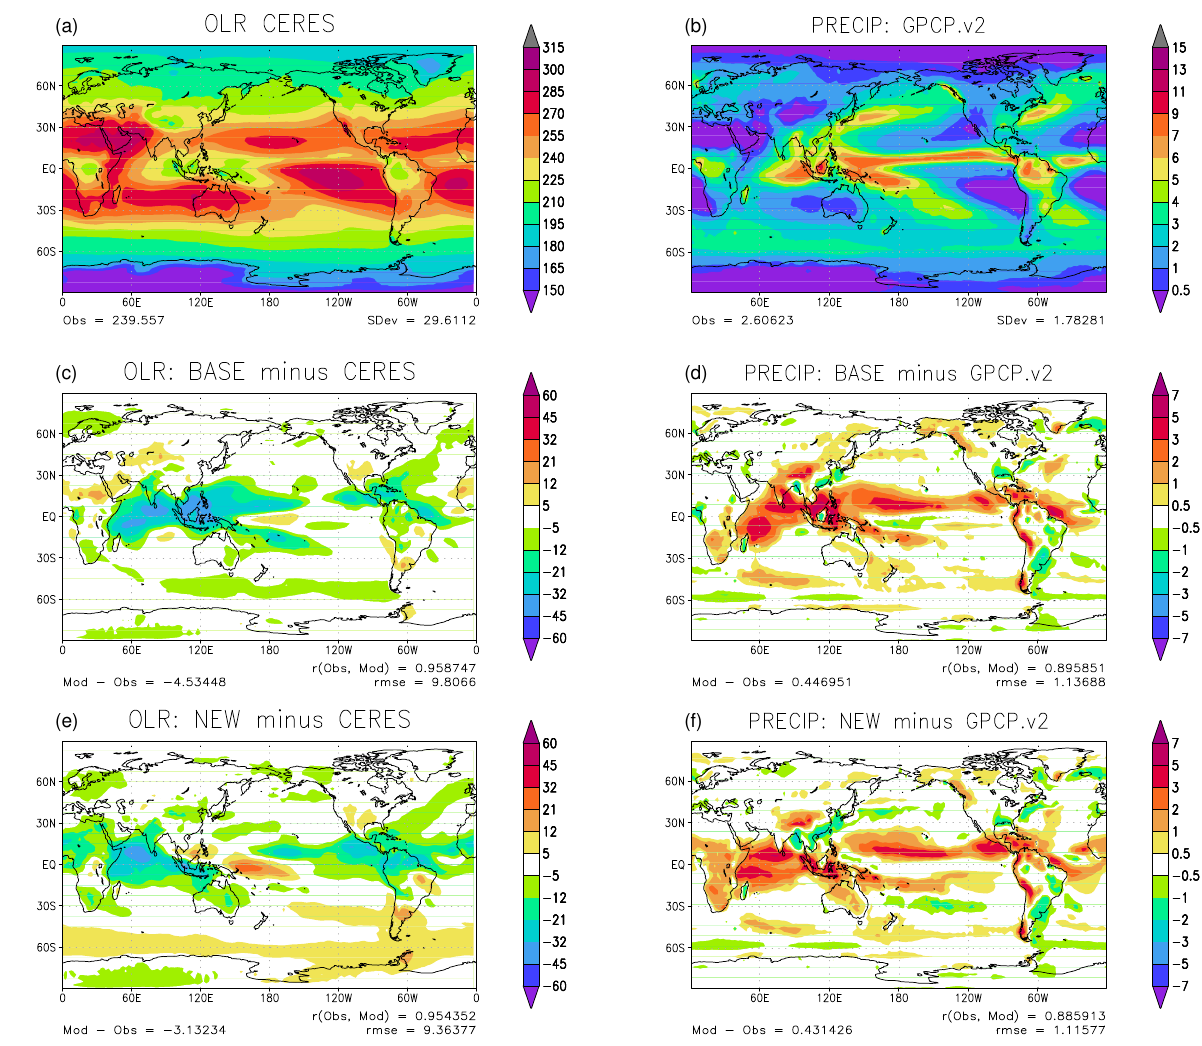
Fig. 12. (a) Outgoing long-wave radiation for March 2000 through February 2005 form the CERES-EBAF dataset (Loeb et al., 2009), (c) difference BASE – CERES-EBAF, (e) NEW – CERES-EBAF, (b) GPCPv2 observation based estimate of surface precipitation, (d) difference BASE – GPCPv2, (f) NEW – GPCPv2. Horizontal averages are indicated in the lower left corner of each panel. SDev is the standard deviation, r(obs,mod) is the correlation coefficient, and rmse the root mean square error (in the lower right corner of each